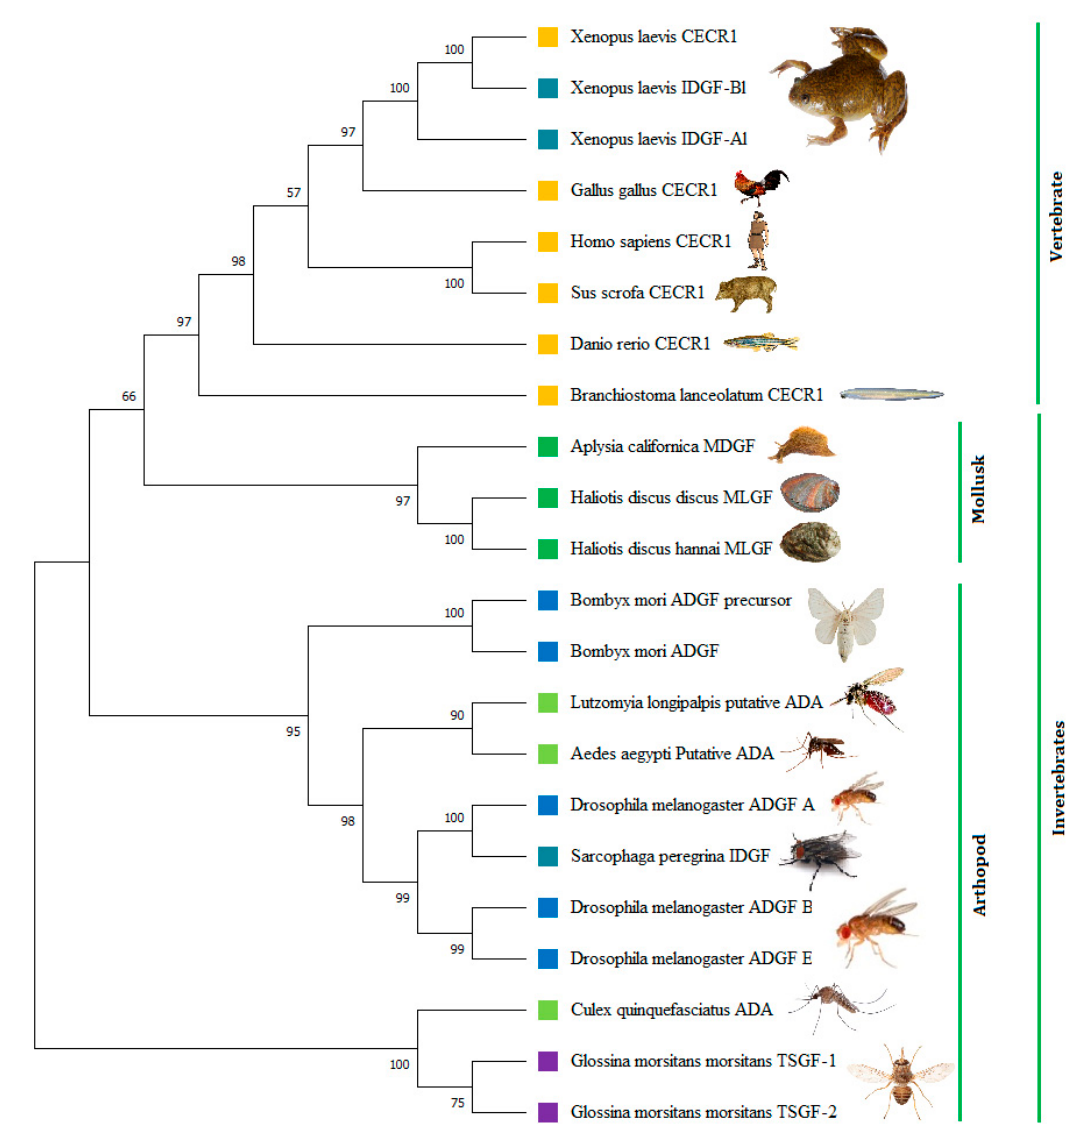
Figure 6. Phylogenetic tree constructed by the bootstrap neighbor-joining method after ClustalW alignment based on the amino acid sequences of different ADGF family members. The numbers at the nodes indicate bootstrap probability. Different colors of squares indicate different genes in the growth factor family ADGF, for instance: the orange square box for CECR1 (specific to vertebrate); green square for mollusks specific growth factor MDGF and MLGF; blue square for ADGF; teal square for IDGF (vertebrate and invertebrates separately formed cluster); lime square for ADA and violet square for TSGF. The sequences with their protein IDs used to construct the phylogenetic tree are as follows: MLGF of H. discus hannai (accession no. ON803449), H. discus (ABO26607.1), MDGF of Aplysia californica (AAD13112.1), IDGF of Sarcophaga peregrina (BAA11812.1), IDGF-Al of Xenopus laevis (AAY42596.1), IDGF-Bl of Xenopus laevis (AAY42597.1), CECR1 of Xenopus laevis (AAX10952.1), Gallus (AAX10953.1), Homo sapiens (CAG30303.1), Sus scrofa (AAL40921.1), Danio rerio (AAL40922.1), Branchiostoma lanceolatum (CAH1231807.1), ADA of Lutzomyia longipalpis (AAF78901.1), Aedes aegypti (AAL76033.1), Culex quinquefasciatus (AAK97208.1), TSGF-1 precursor of Glossina morsitans (AAD52850.1), TSGF-2 of Glossina morsitans (AAD52851.1), ADGF of Bombyx mori (BAF73622.1), ADGF precursor of Bombyx mori (NP_001098698.1), ADGF A of Drosophila melanogaster (AAL40913.1), ADGF B of Drosophila melanogaster (AAL40920.1), and ADGF E of Drosophila melanogaster